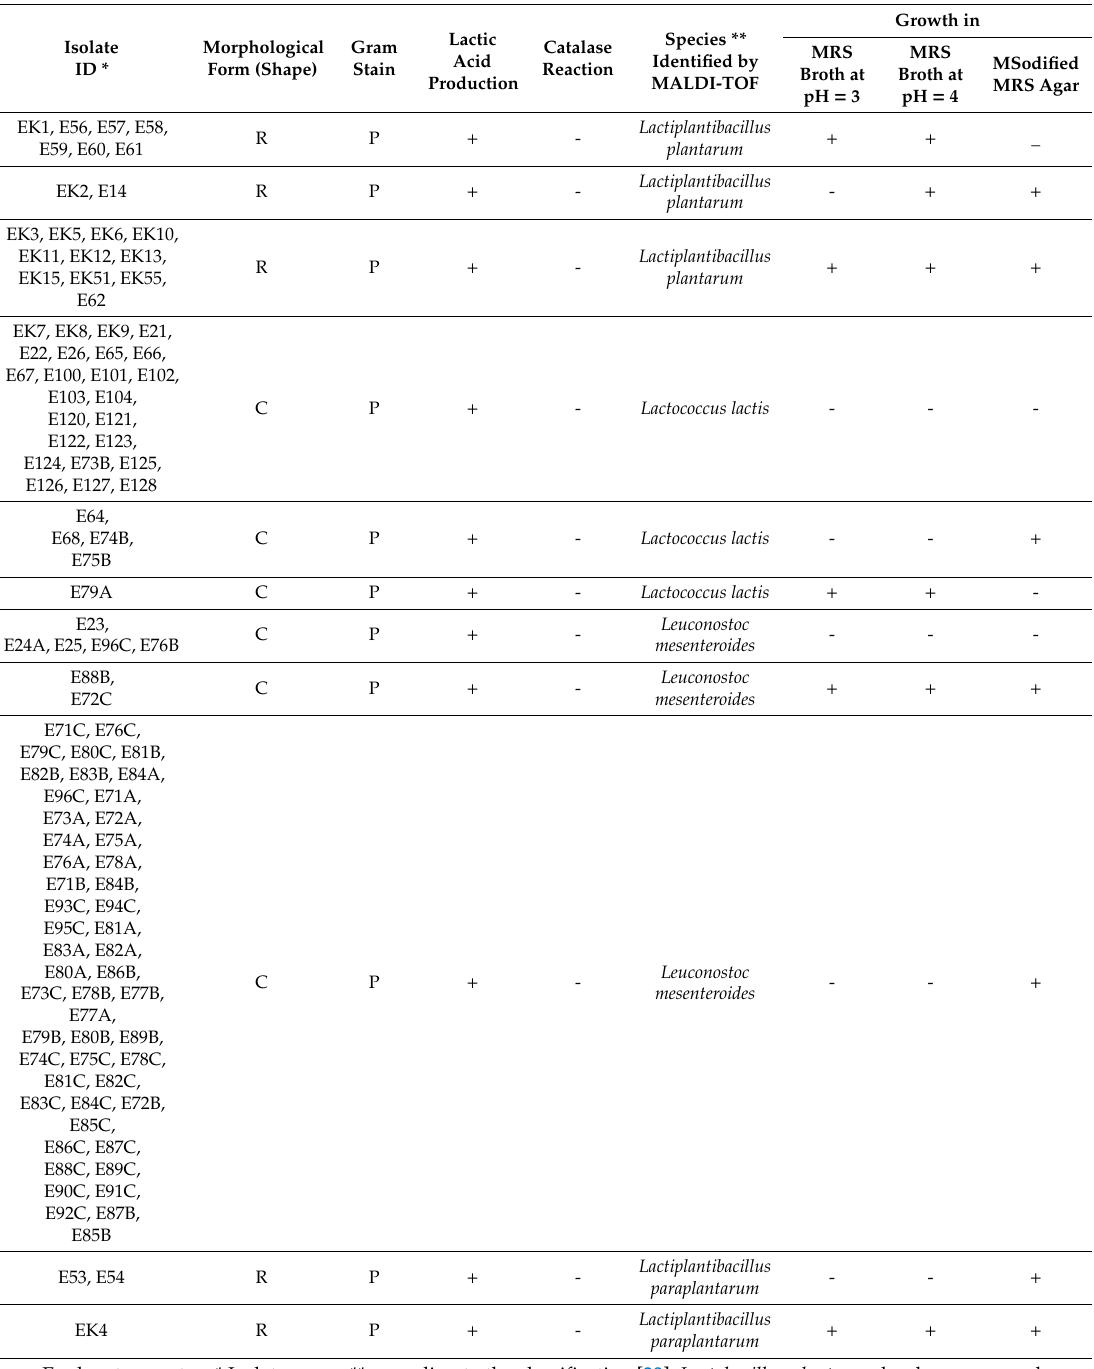
Table 1. Species identification (MALDI-TOF Biotyper) and comparison of the characteristics of lactic acid bacteria